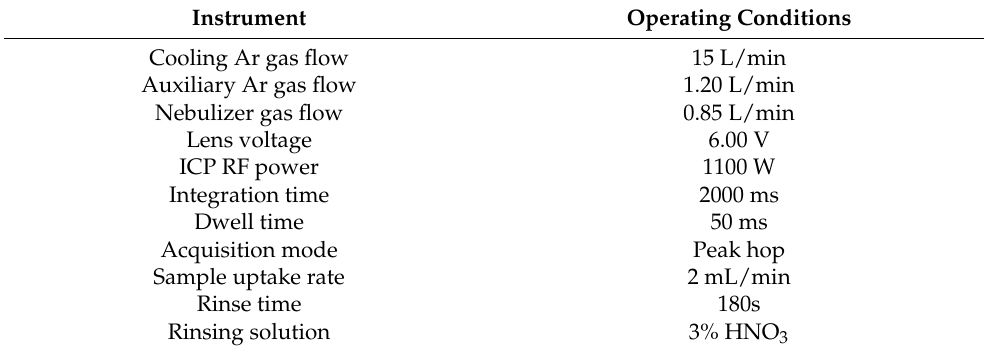
Table 6. ICP-MS instrumental conditions for the determination of chemical elements in sediment